Question: Write a single sentence explaining what this figure depicts.
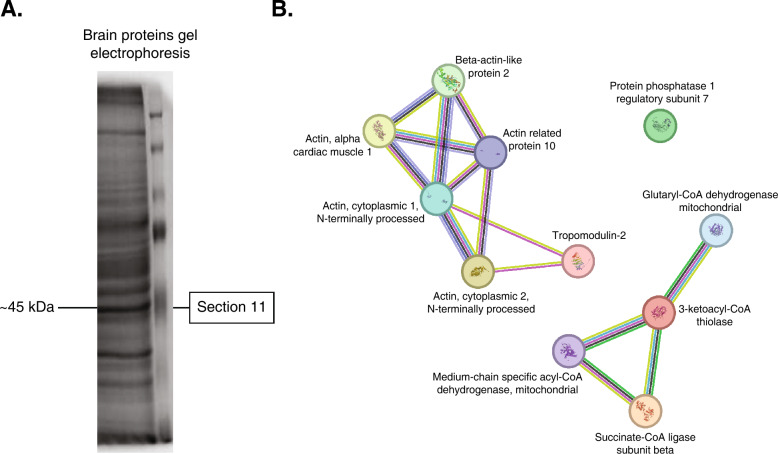
Answer: Identification and characterization of proteins contained in Sect. 11. A Protein identification by mass spectrometry analysis of the ~ 45 kDa band corresponding to Sect. 11. Eleven human proteins were identified with a spectral abundance ratio greater than 60%, as described in the Materials and Methods section. B Protein–protein interaction network of the proteins identified in Sect. 11, highlighting cytoskeletal and metabolic clusters. Network analysis was performed using STRING (Search Tool for the Retrieval of Interacting Genes/Proteins)